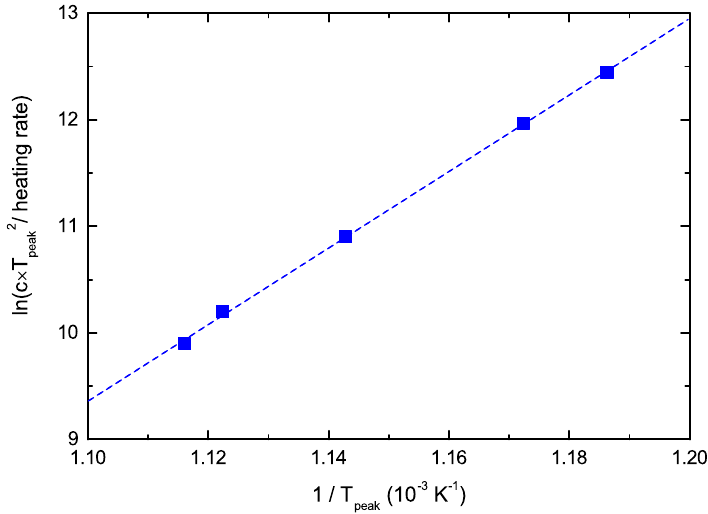
Figure 7. Determination of the pre-exponential factor ν : Plot of Equation (7) as a function of 1/T peak